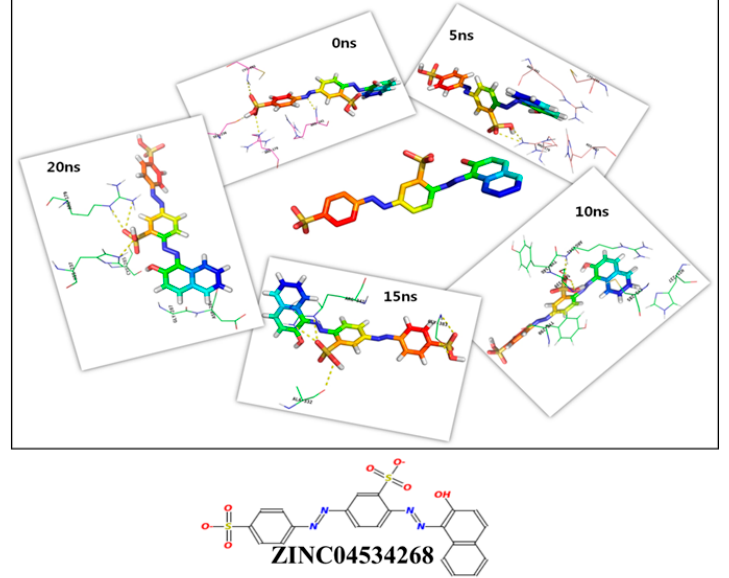
Figure 4. Binding mode of ZINC04534268 with active site residues of caspase 8 at different time intervals.